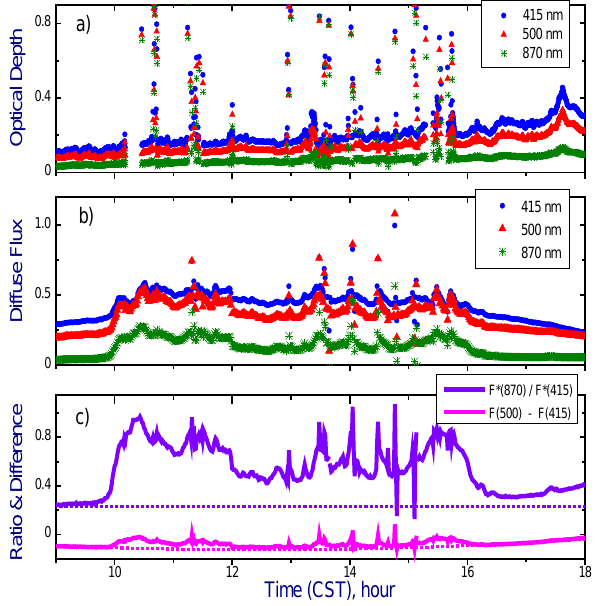
Fig. 1. Temporal realizations of optical depth at three wavelengths Fig. 1 . Temporal realizations of AOD at three wavelengths (415, 500, and 870 (415, 500, and 870nm) (a) , the corresponding all-sky diffuse fluxes nm) (a), the corresponding all-sky diffuse fluxes (b), and the diffuse transmittance (b) , and the diffuse transmittance ratio and difference of diffuse ratio and difference of diffuse fluxes (c) for July 28, 2007. Violet dotted and fluxes (c) for 28 July 2007. Violet dotted and magenta dotted lines magenta dotted lines (c) represent the “clear-sky” baselines for the diffuse (c) represent the “clear-sky” baselines for the diffuse transmittance transmittance ratio and diffuse flux difference, respectively. ratio and diffuse flux difference,